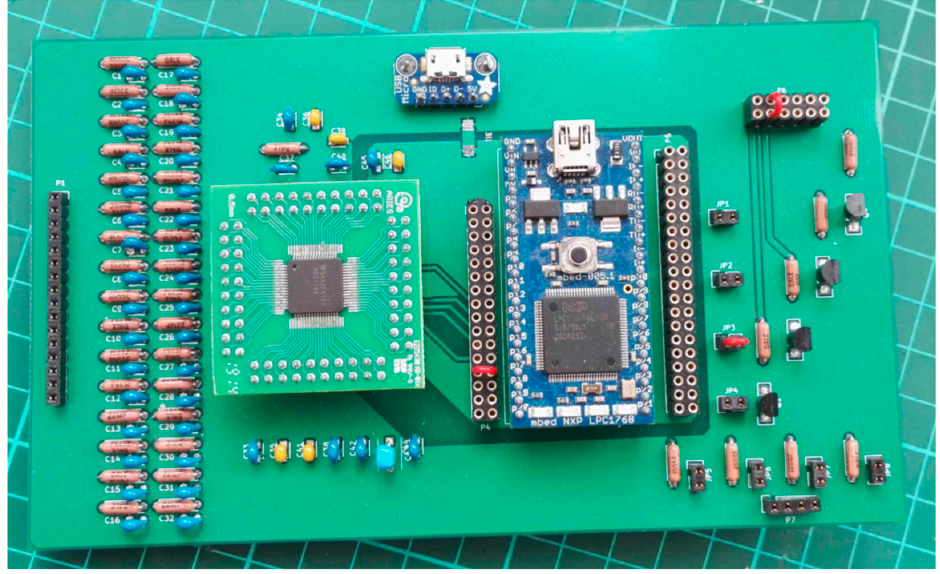
Figure 2. Acquisition board only, where inputs are on the left and outputs for LED are on the bottom right.